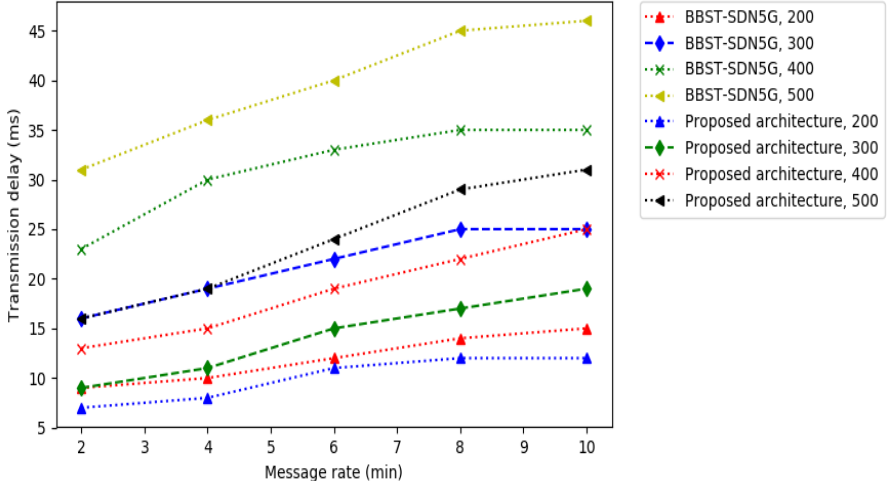
Figure 6. Transaction transmission